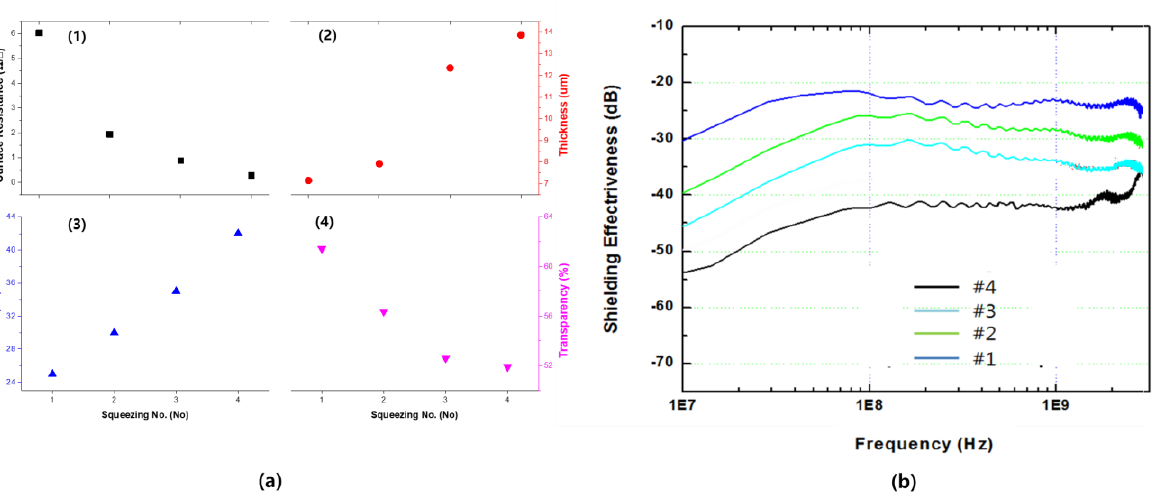
Figure 8. Evaluation of film properties and electromagnetic shielding properties according to coating conditions. ( a ) Main performance evaluation result by number of squeezing. 1: Surface resistance, 2: filling thickness, 3: shielding effectiveness at 1 Ghz, and 4: transparency. ( b ) Shielding effectiveness change according to frequency change.